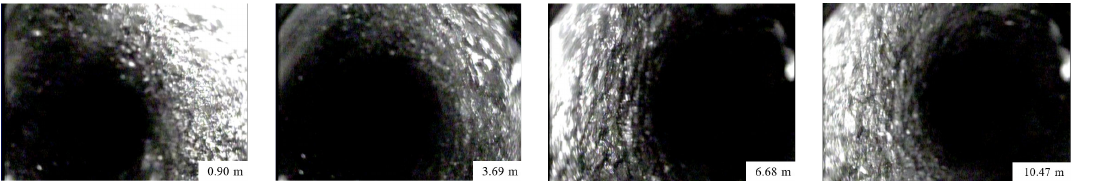
Figure 20. Borehole imaging diagram of the surrounding rock structure of the coal pillar (before the first mining).